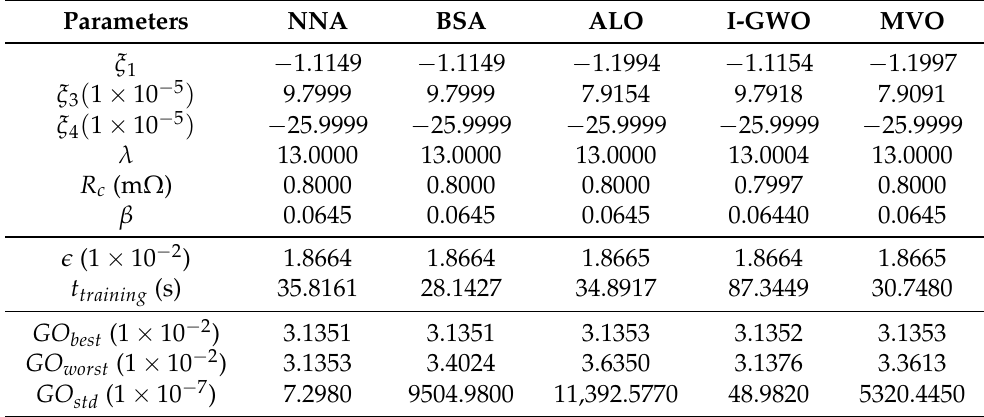
Table 5. Unknown parameters computed and performance information for the modeled polarization curve at 18%